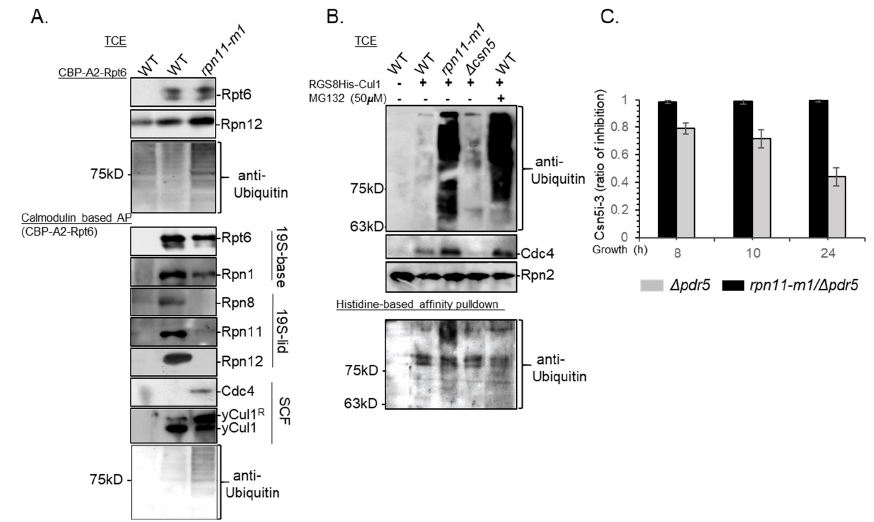
Figure 4. SCF complexes of rpn11-m1 are loaded with ubiquitinated substrates and co-interact with the 19S proteasome. ( A ) WT and rpn11-m1 mutant cells were transformed with a plasmid